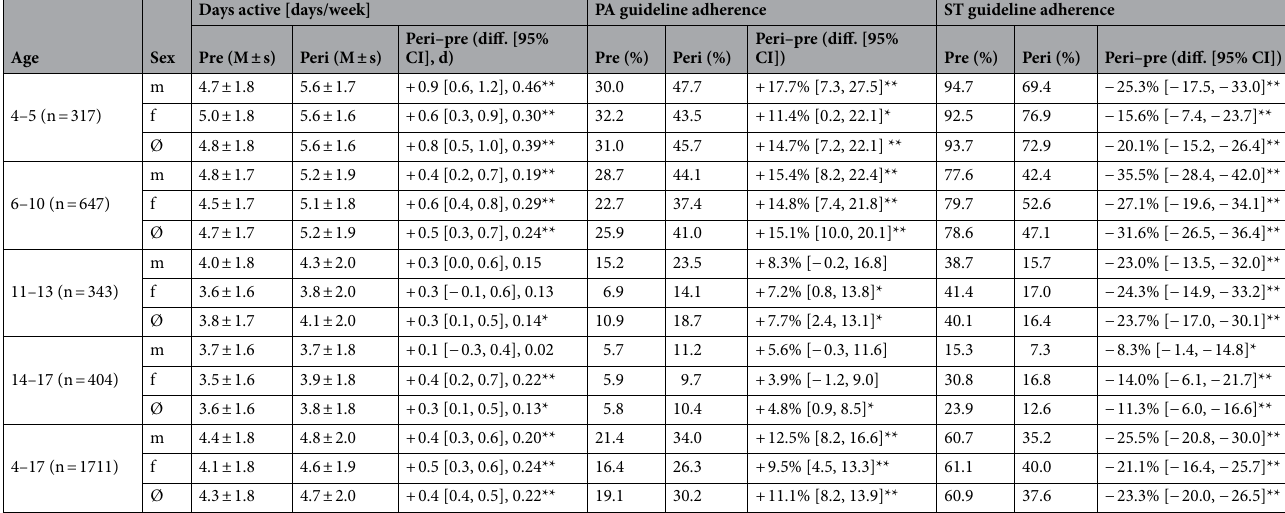
Table 1. Overall physical activity and guideline adherence before and during the COVID-19 lockdown in Germany (MoMo Study). PA guideline adherence: being physically active for 60 min or more a day during a normal week; ST guideline adherence: Using recreational screen time media for 120 min or less a day during a normal week. m male, f female, Ø mean of males and females, M mean, s standard deviation, diff. difference